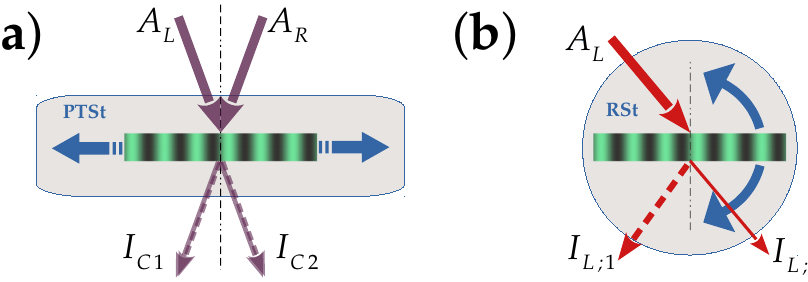
Figure 2. Schematic of the experimental setup for ( a ) a two-beam coupling (2BC) experiment and ( b ) an angular selectivity experiment. PTSt: piezo-translation stage; RSt: rotation stage. A L , R are the amplitudes of the incident beams; I C 1, C 2 the coupled intensities. I L ; s are the intensities of the s -th-order diffracted